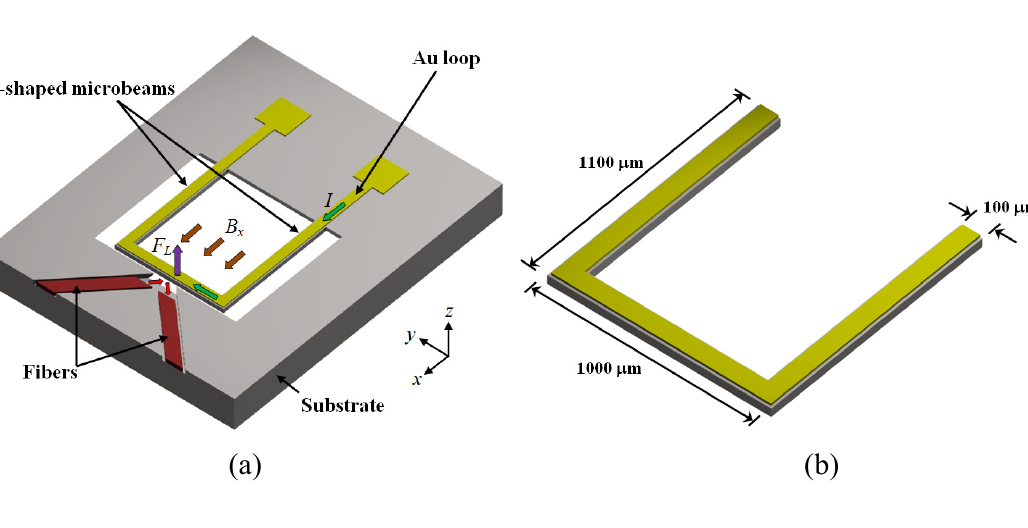
Figure 9. (a) Schematic view of an operation principle and (b) dimensions of a magnetic field sensor by Keplinger et al .